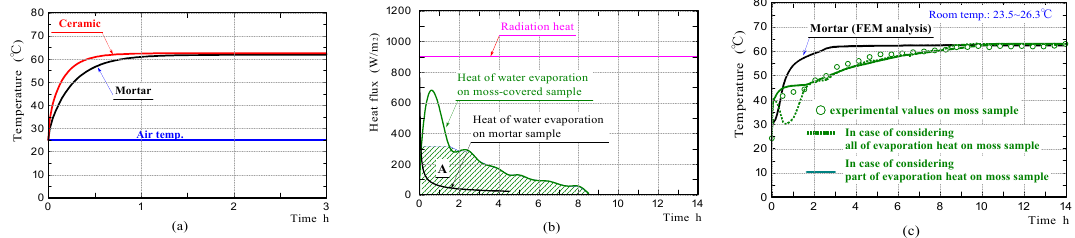
Figure 11. Surface-temperature changes of the mortar and ceramic samples in the non-water absorbing state obtained by FEM analyses ( a ), heat of water evaporation ( b ), and surface-temperature changes of the mortar and moss-covered samples in the water absorbing state ( c ) obtained by experiments and FEM analyses.